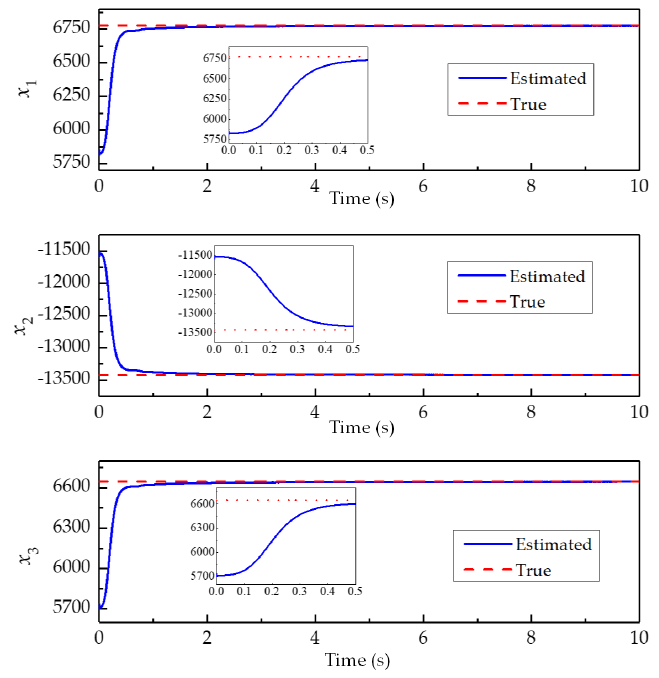
Figure 5. Evolutions of the estimated system model parameter.